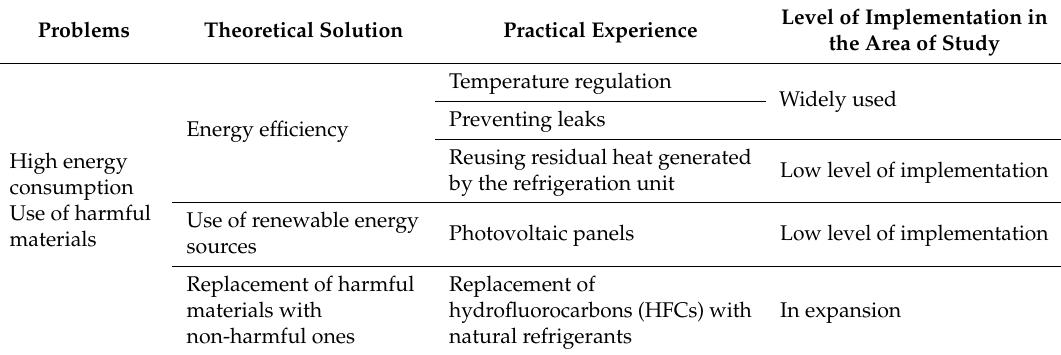
Table 11. Main solutions based on the CE for refrigeration